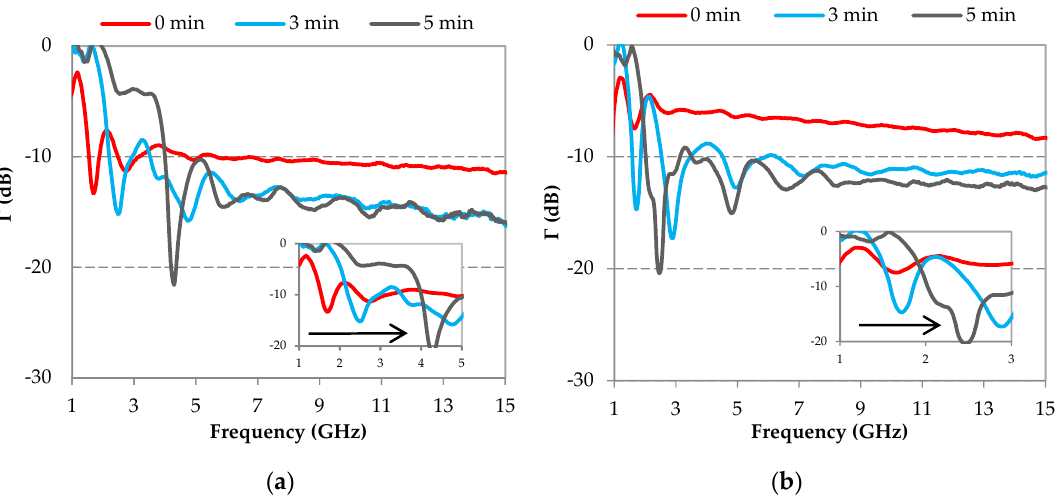
Figure 8. Frequency dependence of the measured reflection coefficient for epoxy foams loaded with 0.5 wt.% of ( a ) 3 mm-CFs and ( b ) 6 mm-CFs obtained with three times of shear mixing: 0 min, 3 min, and 5 min.